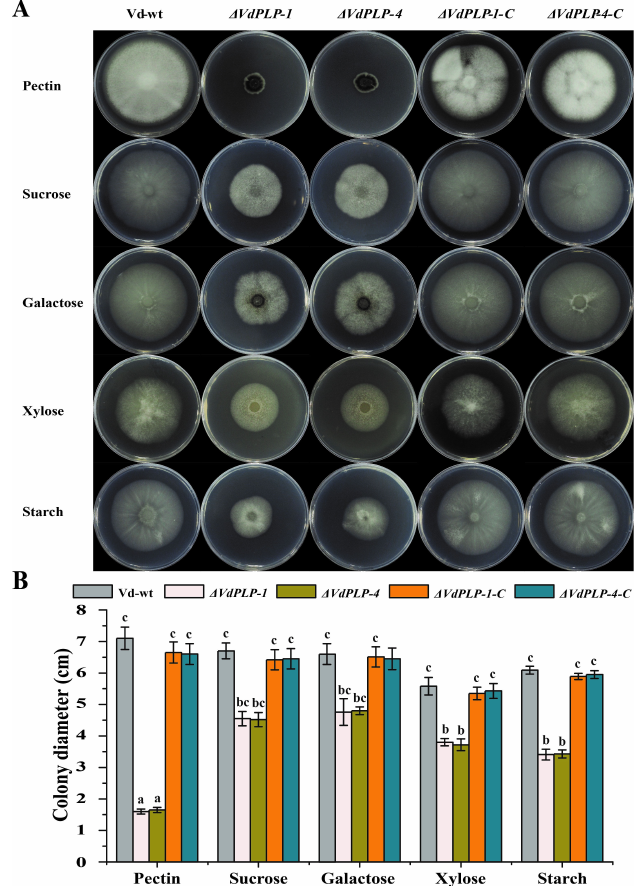
Figure 2. Mycelial growth of Vd-wt, ∆ VdPLP ( ∆ VdPLP-1 and ∆ VdPLP-4 ) strains and complementary ∆ VdPLP strains ( ∆ VdPLP-1-C and ∆ VdPLP-4-C ) strains after 15 days on minimal medium (MM) agar with different carbon sources: ( A ) colony morphology; and ( B ) colony diameters. Values represent the mean ± standard deviation (SD) from three independent replicates, Different letters (a–c) above the bars represent the significant differences among the groups ( p -value < 0.05) and the data were analyzed using Duncan’s multiple range